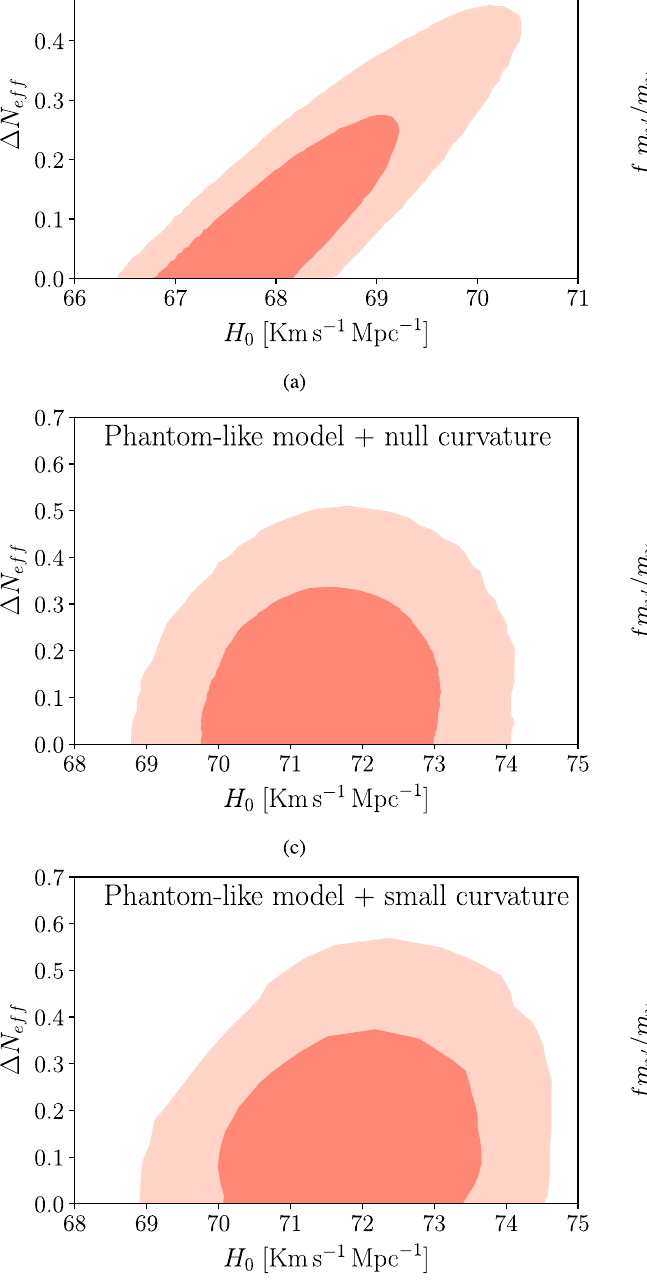
Fig. 1 Allowedregionsofparametersthatconnectourmechanismand the value of Hubble constant in phantom-like cases. The first row cor- responds to the (cid:2) CDM model, and in the second and third rows a phantom-like quintessence is introduced, first in a spatially flat model, then with non-null spatial curvature. The second column presents the cases corresponding to a non-zero (cid:9) N ef f . The data set that connects